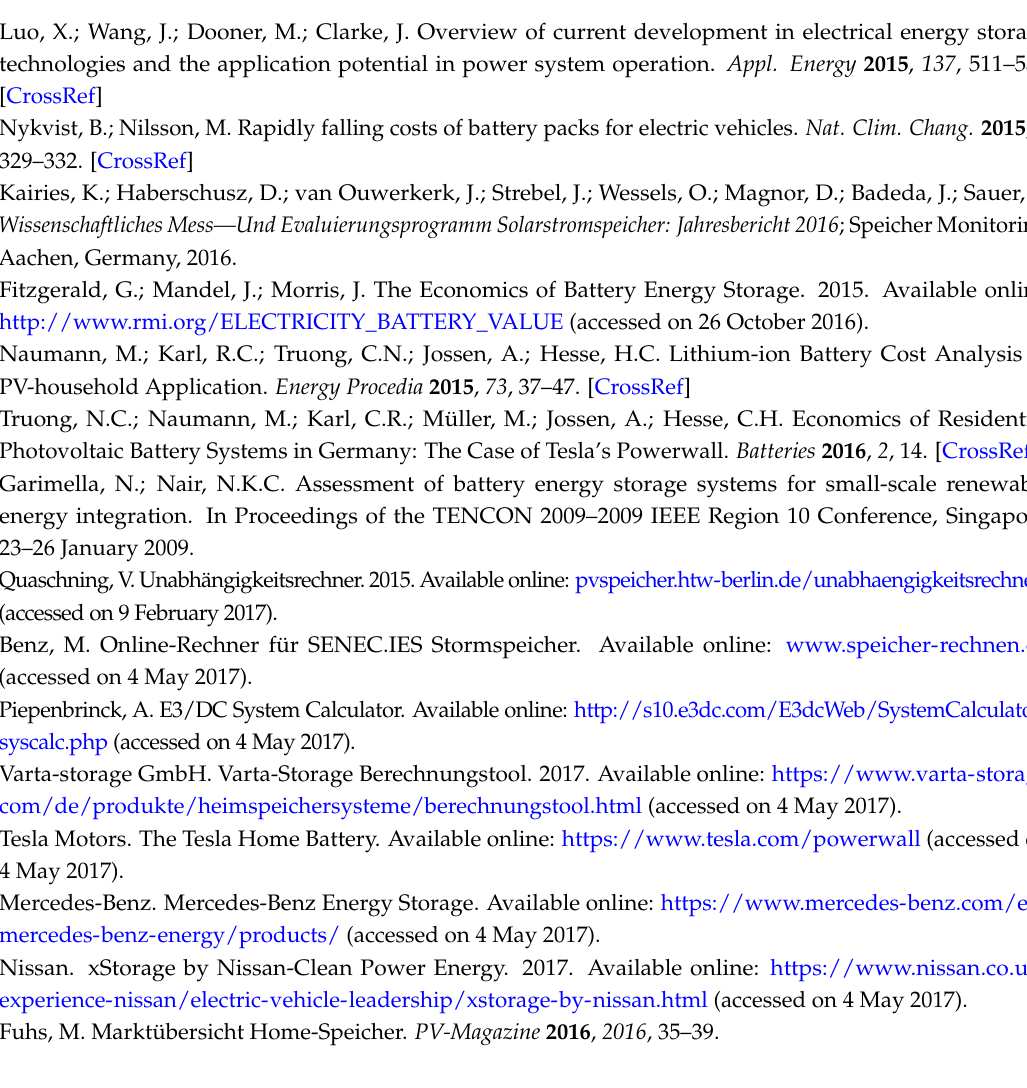
according to the scenarios described in the paper. The load profile was taken from [38].